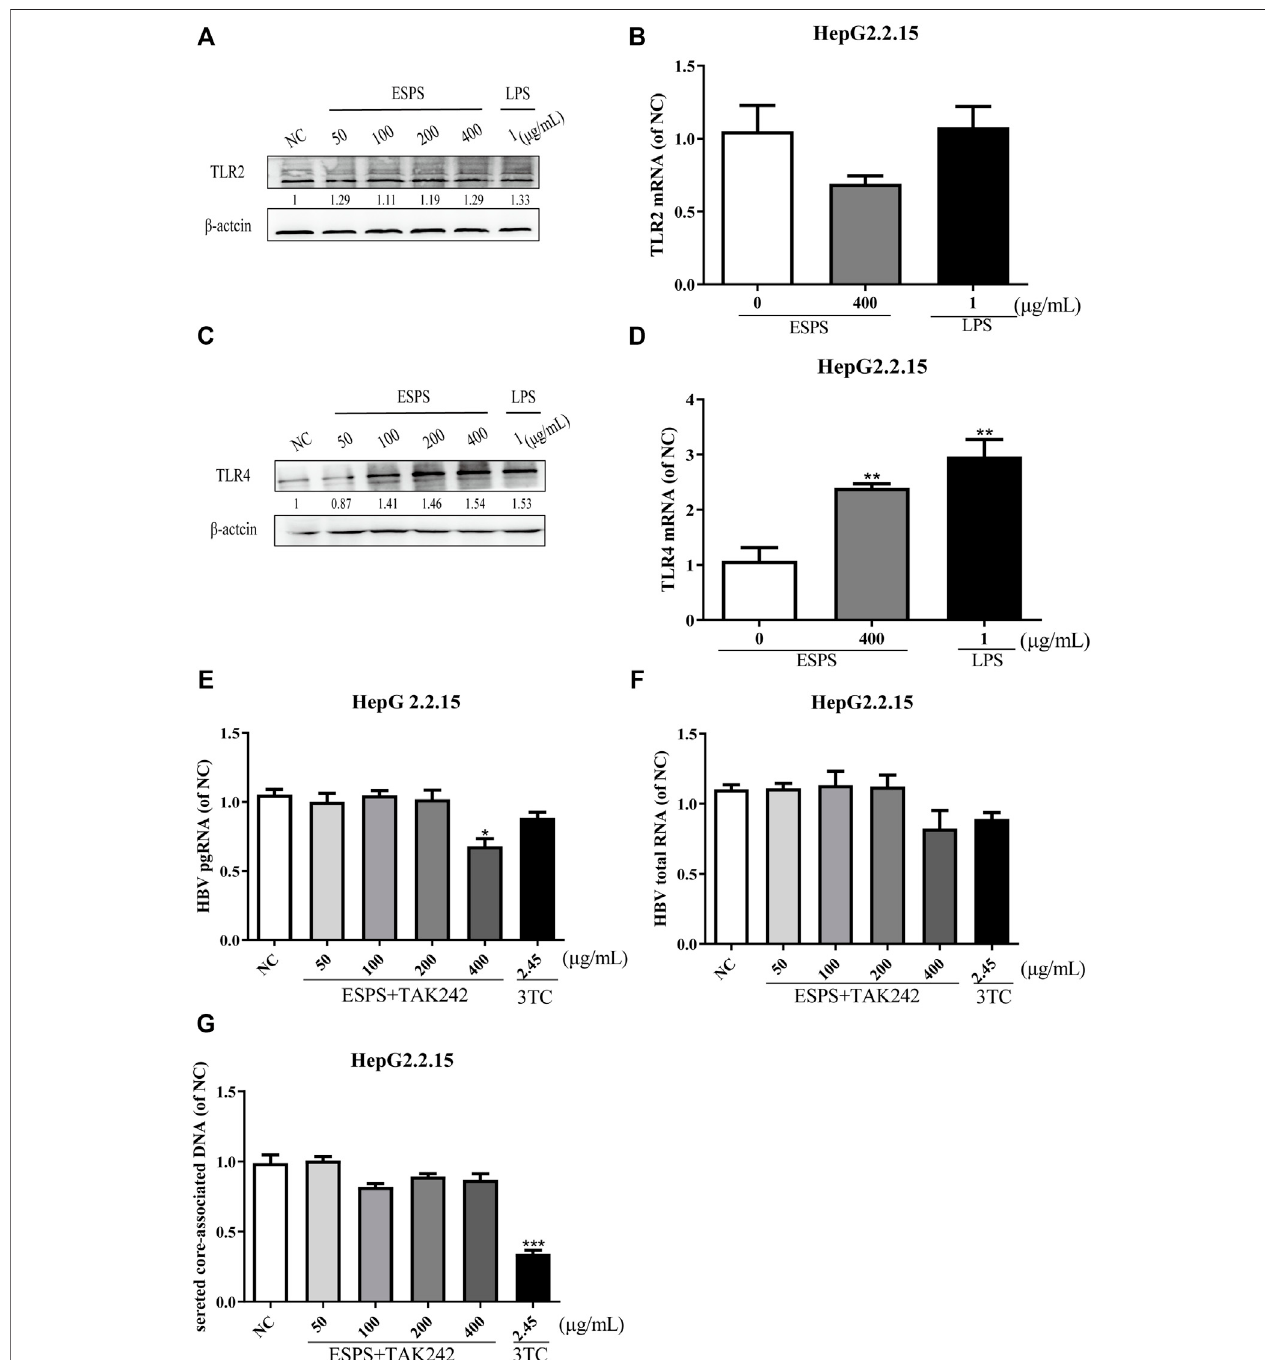
FIGURE2| ESPSinhibitHBVreplicationthroughTRL4pathway.HepG2.2.15cellsweretreatedwithindicatedcompoundsfor16 h;theproteinlevelsofTLR2and TLR4wereevaluatedbywesternblottinganalysis (A,C) .ThenthemRNAlevelofTLR2andTLR4wasevaluatedbyQ-PCR (B,D) .HepG2.2.15cellsweretreatedwiththe inhibitor of TLR4 (TAK242) and ESPS, qPCR was used to evaluate the HBV pgRNA (E) and total mRNA (F) after 6 days, and HBV core-associated DNA (G) was evaluated after 9 days. Values are means ± SD ( n = 3). * p < 0.05, ** p < 0.01, *** p < 0.001 vs . control group.